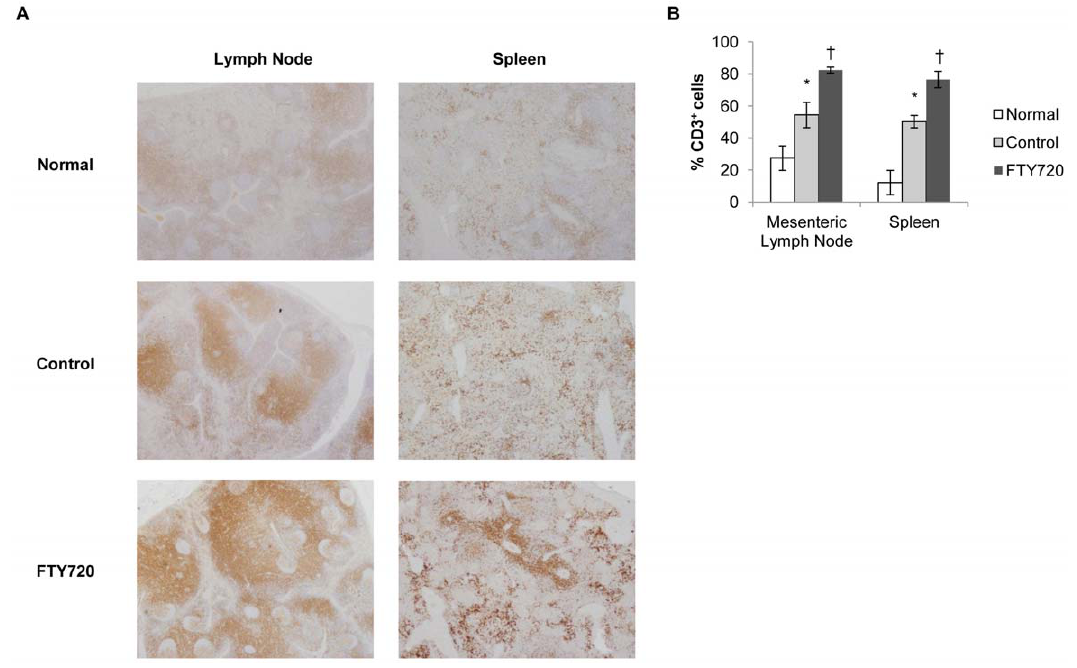
Figure 5. Central lymphocyte counts at time of necropsy. a ) Representative immunohistochemistry pictures (20 6 magnification) of anti-CD3 staining of normal, control, and FTY720 mesenteric lymph node and spleen tissue. b ) Quantification of anti-CD3 reactivity by ACIS. * indicates p , 0.05 compared to normal, unmanipulated tissue; { indicates p , 0.05 compared to control. Data is depicted as mean 6 SEM.